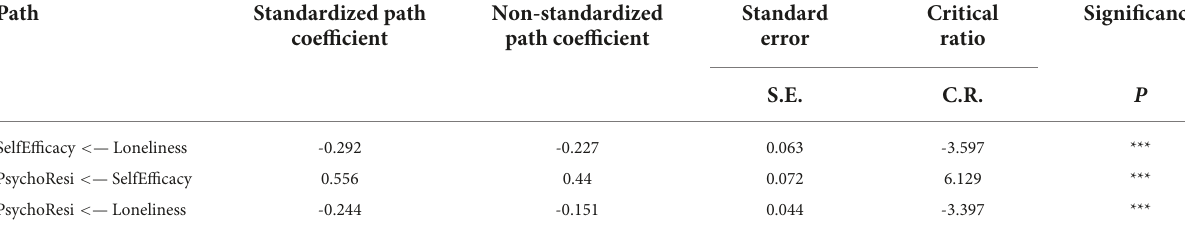
TABLE 3 Path analysis results.